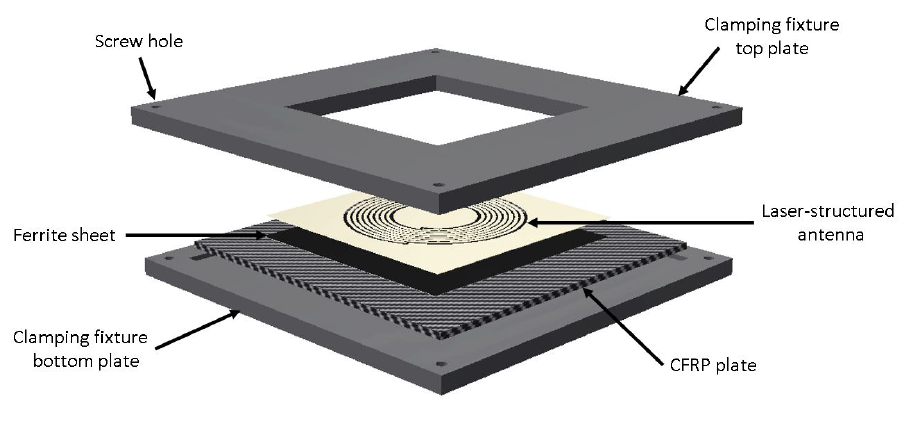
Figure 5. Schematic representation of clamping